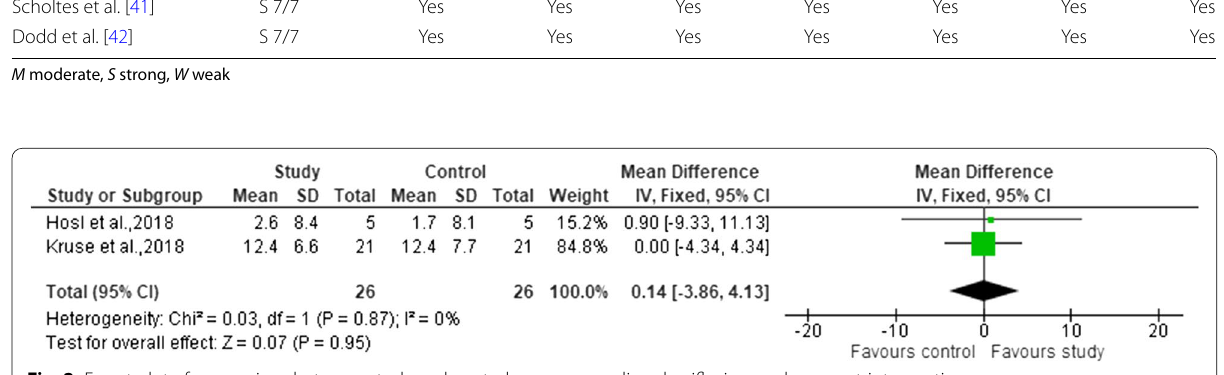
Fig. 2 Forest plot of comparison between study and control groups regarding dorsiflexion angle —